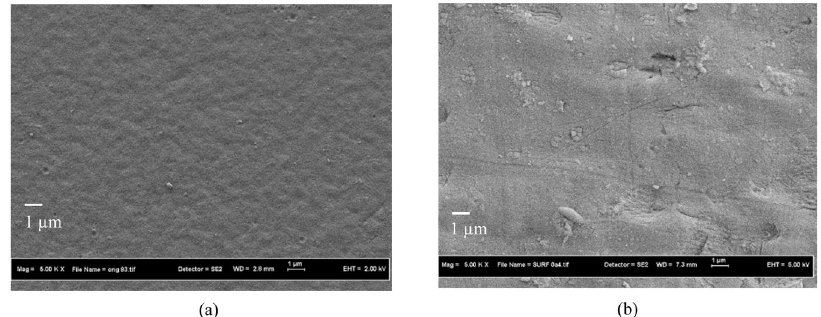
Figure 5. FESEM images of PES substrate, ( a ) top surface and ( b ) bottom surface.